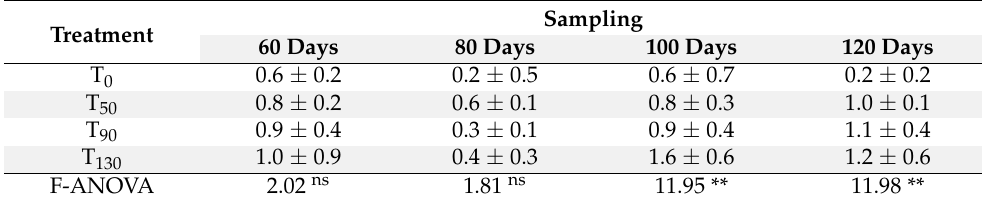
Table 12. Chromium content ( µ g/L) in leachates. Entries represent means ± standard errors from n = 3 replicates. Treatment